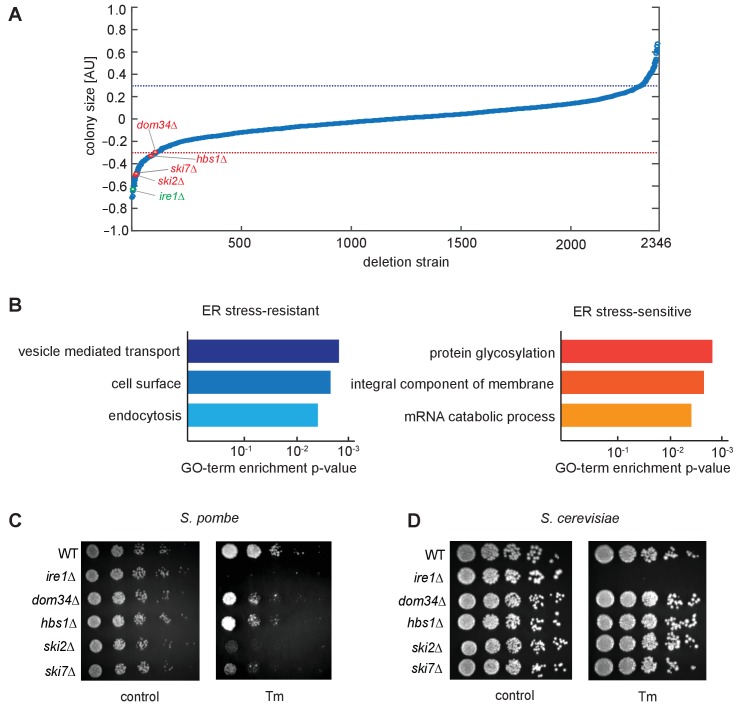
Genetic screen for factors involved in the unfolded protein response. (A) A chemical genetic screen of a non-essential deletion library. Each strain is plotted against the log ratio of colony size with and without addition of the ER stress inducer tunicamycin (Tm). Significant sensitive or resistant genes were identified by a standard-score (z-score) >2 (blue line) or <−2 (red line), corresponding to colony sizes measuring more than two standard deviations from the mean. Strains of interest missing no-go or nonstop decay factors (red) and the unfolded protein response factor ire1 (green) are indicated. All tested strains are listed in Supplementary file 1. (B) Gene-ontology (GO) analysis of enriched sensitive or resistant genes. (C, D) Viability assay by serial dilution of either S. pombe or S. cerevisiae wild type, ire1Δ, dom34Δ, hbs1Δ, ski2Δ and ski7Δ cells spotted on solid media with or without Tm (S. pombe: 0.03 µg/ml; S. cerevisiae: 0.3 µg/ml). Plates were photographed after 3 days of growth at 30°C. Note that although ski2Δ cells did not form colonies upon plating on Tm-containing media, they survived long enough after DTT addition in liquid media to allow for the footprinting analyses performed in this work.